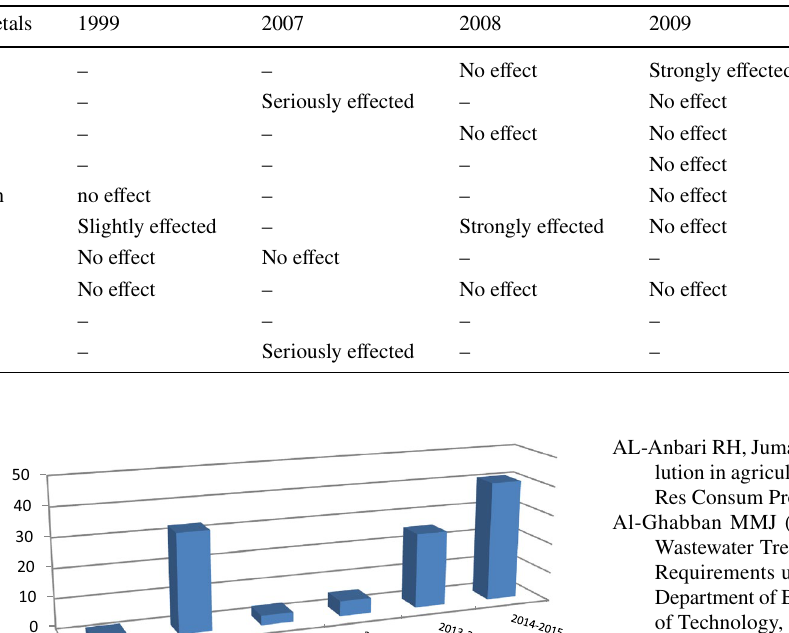
Table 7 PI evaluation of each element throughout the years